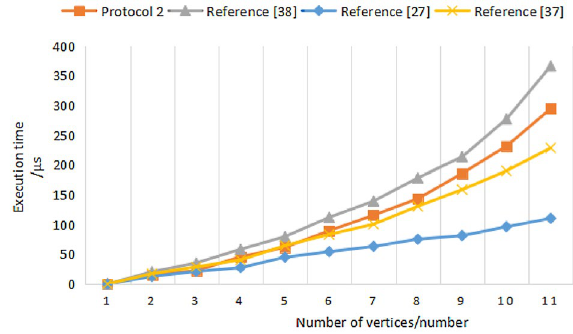
Figure 7. Comparison of the execution time of three protocols.